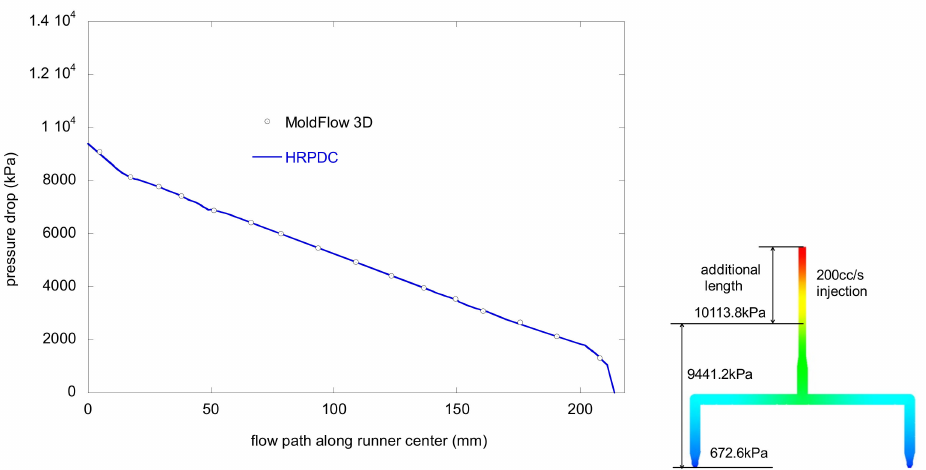
Figure 11. Pressure drop along the flow path for flow rate of 200 cc/s at 240 ◦ C for the dimensions in Figure